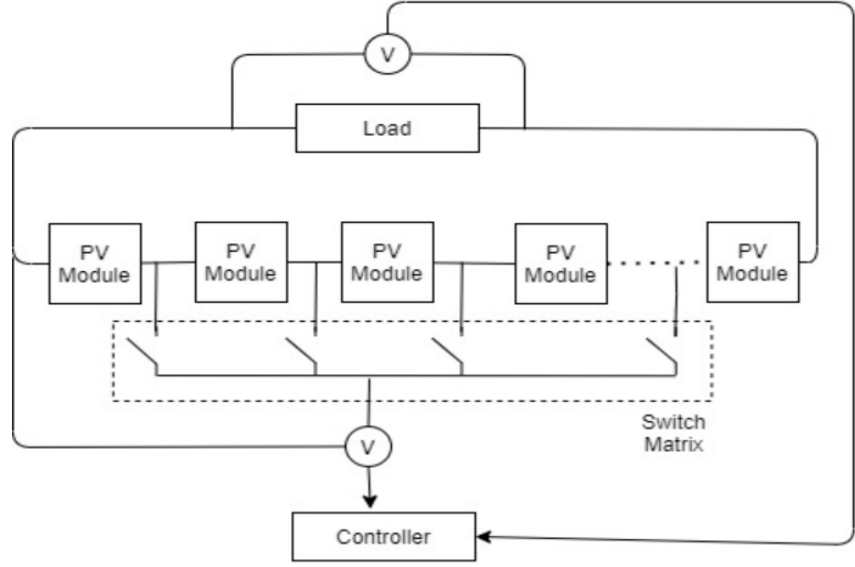
Figure 1. Block diagram for the proposed shading detection system mentioned in [51].